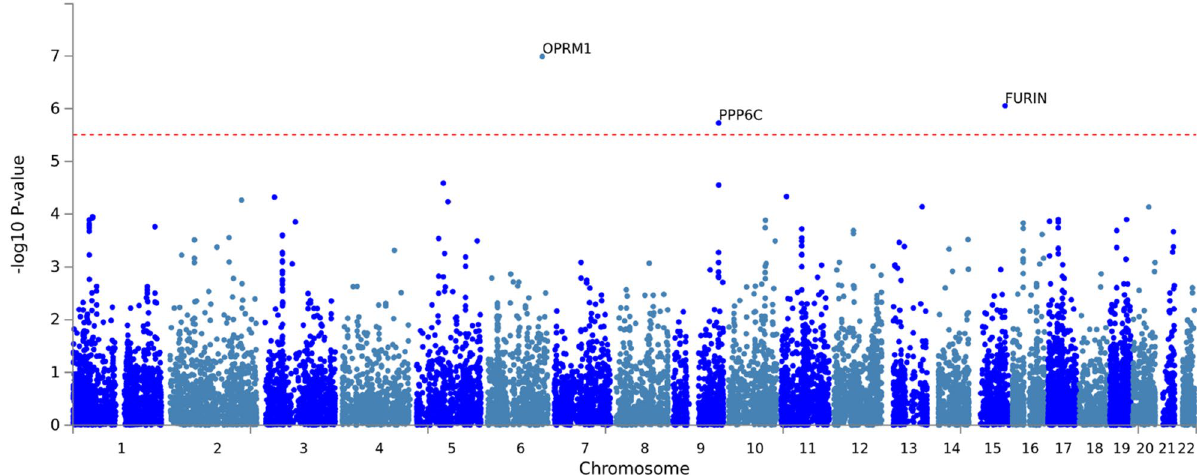
Figure 4. Gene-level Manhattan Plot. GWAS results were summarized at the gene-level using MAGMA. Bonferroni correction was used to correct for multiple comparisons; associations with P < 3 × 10 –6 (indicated by horizontal red dotted line) were genome-wide